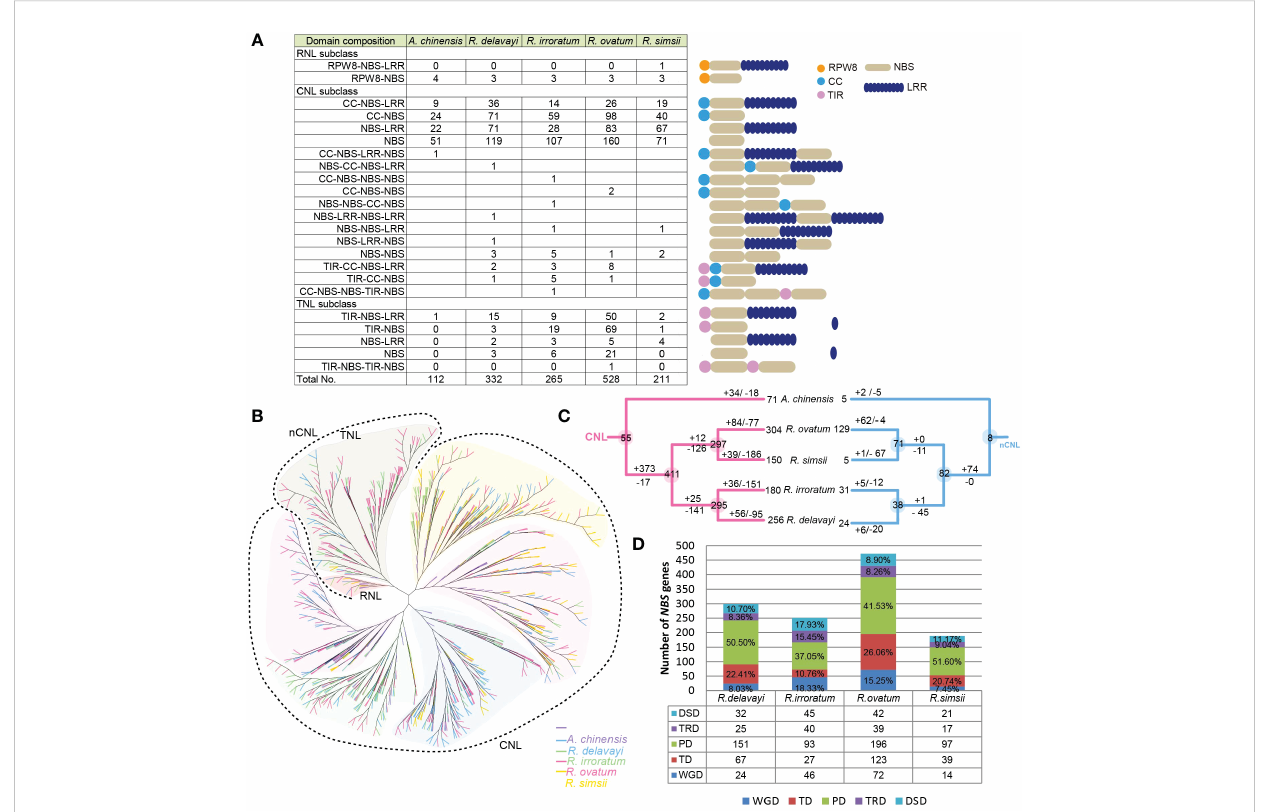
FIGURE 5 NBS-encoding gene evolution in Rhododendron . (A) Number of the NBS-encoding genes in each category in four Rhododendron species and kiwifruit. Twenty-three domain combinations were found. The numbers listed in table represented the number of genes for each domain combination. ‘ R ’ , ‘ C ’ , ‘ T ’ and ‘ N ’ were the abbreviations of RPW8, CC, TIR and NBS domains. Genes with both CC and TIR domains were clustered into CNL clade based on phylogenetic analysis. (B) The NBS-encoding gene phylogenetic tree for four Rhododendron species and kiwifruit; (C) Duplications/losses of the NBS-encoding genes during the evolutionary processes of Rhododendron . The number of ancestral genes for each node was shown in circles. Gene duplications or losses on each branch were illustrated by numbers with + or – symbols, respectively; (D) Numbers of NBS-encoding genes produced by different gene duplication events in four Rhododendron